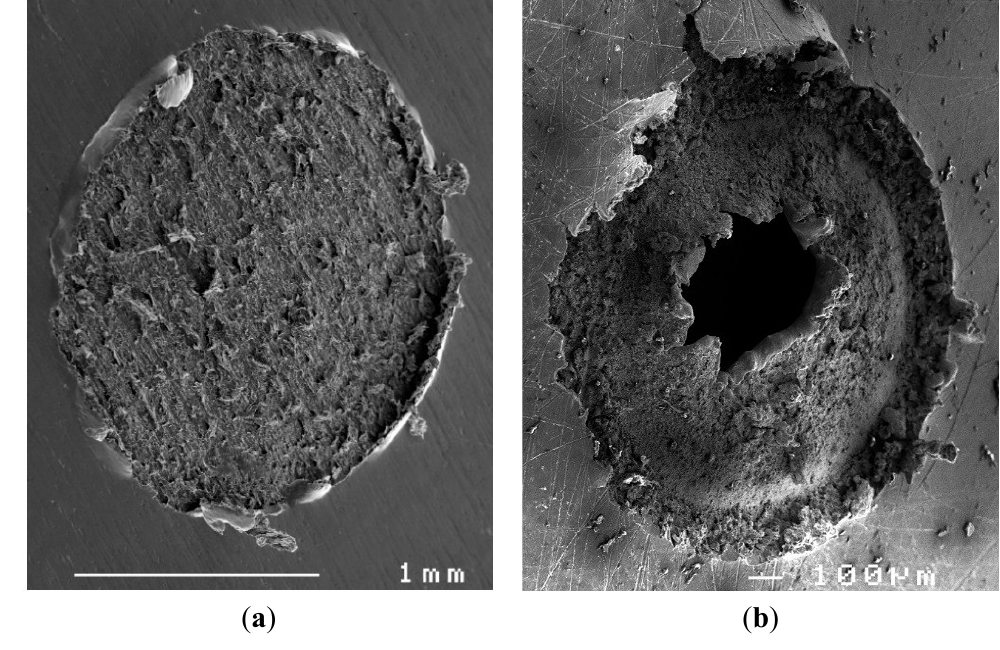
Figure 9. Scanning electron micrographs of a 250 µm-thick Fe target recovered after a